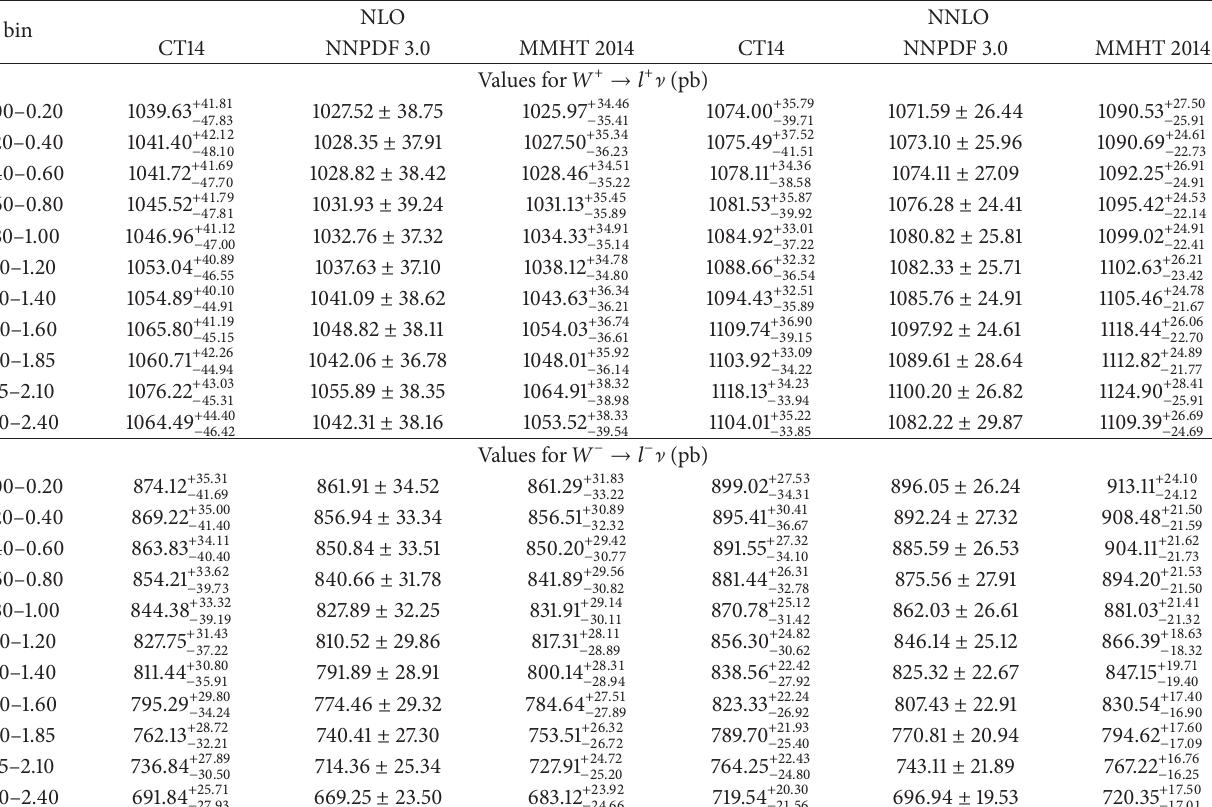
Table 2: Predicted differential cross section numbers for CT14, NNPDF 3.0, and MMHT 2014 PDFs at √𝑠 = 13 TeV. All numbers are in units of pb.